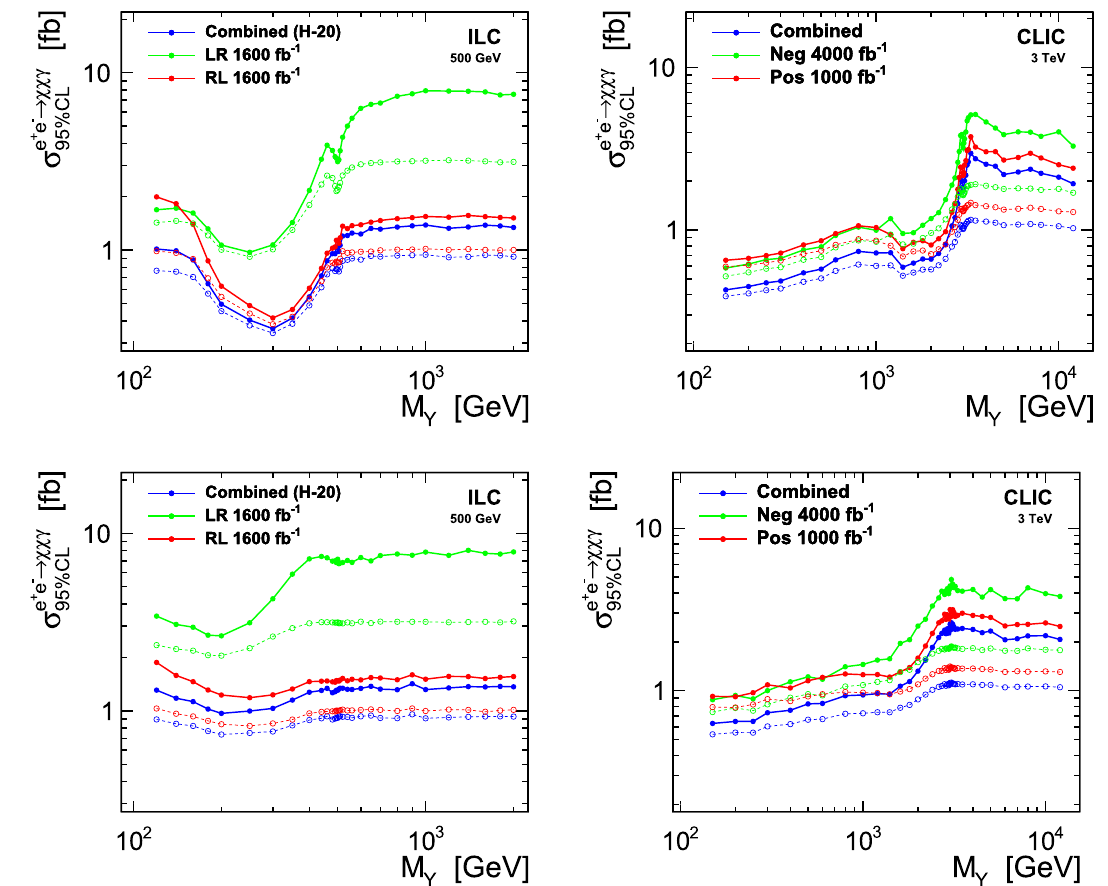
Fig. 10 Limits on the cross section for the radiative light DM pair-production processes with vector mediator exchange at 500GeV ILC (left) and 3TeV CLIC (right). Limits extracted with (solid line) and without (dashed line) taking into account systematic uncertainties are compared for narrow mediator ( (cid:4)/ M = 0 . 03; top row) and wide mediator ( (cid:4)/ M = 0 . 5; bottom) hypotheses